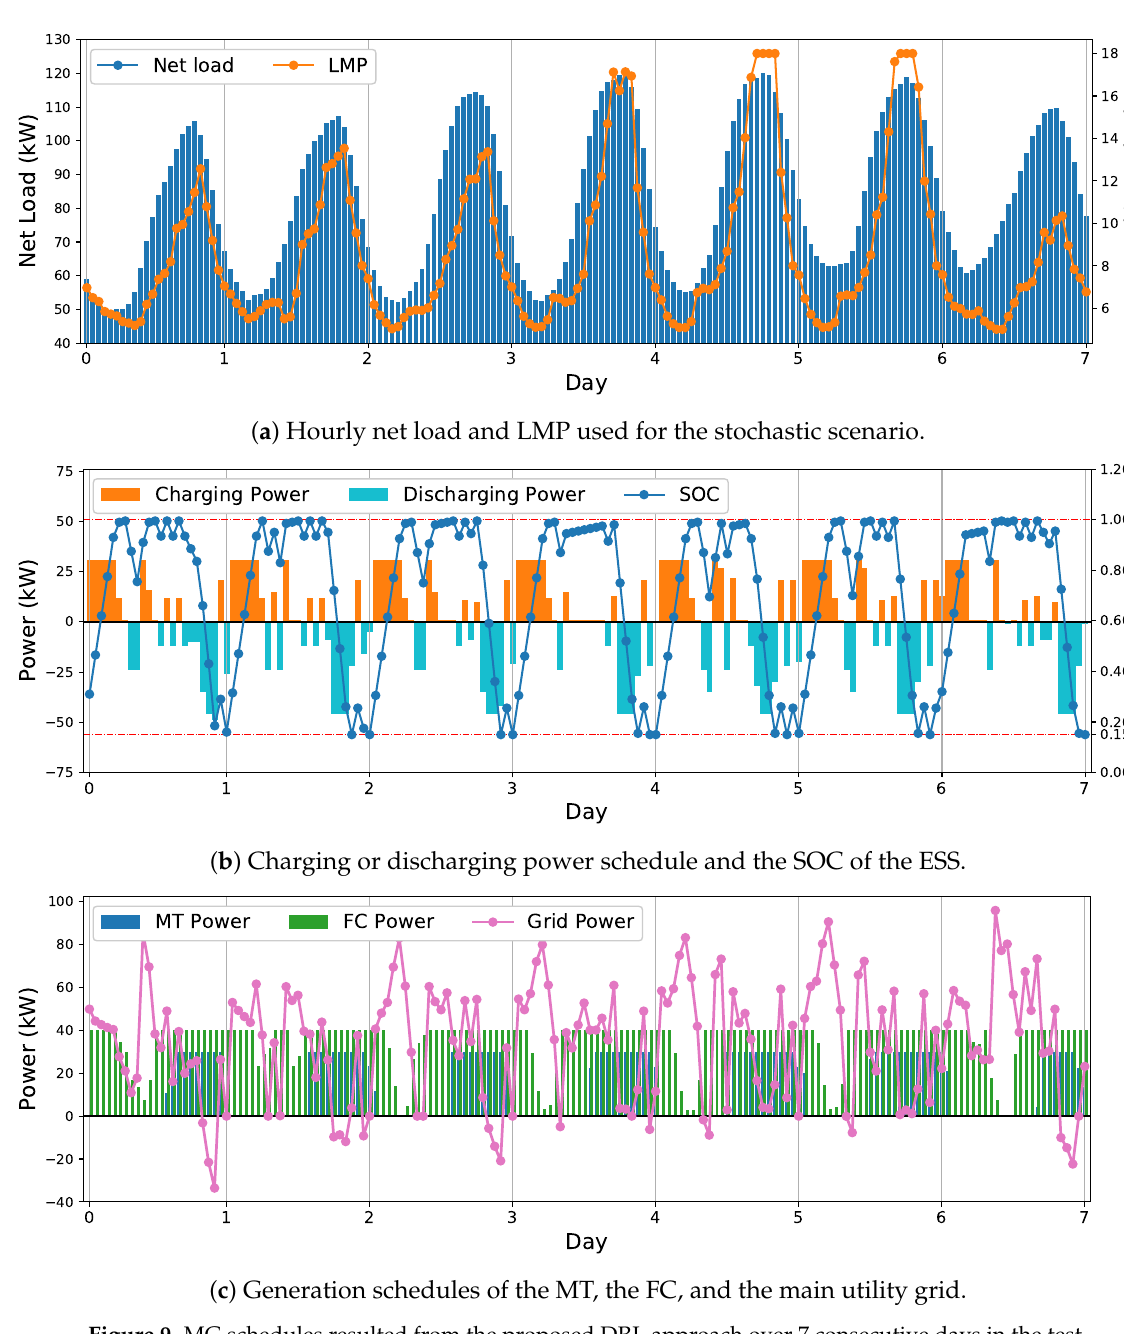
Figure 9. MG schedules resulted from the proposed DRL approach over 7 consecutive days in the